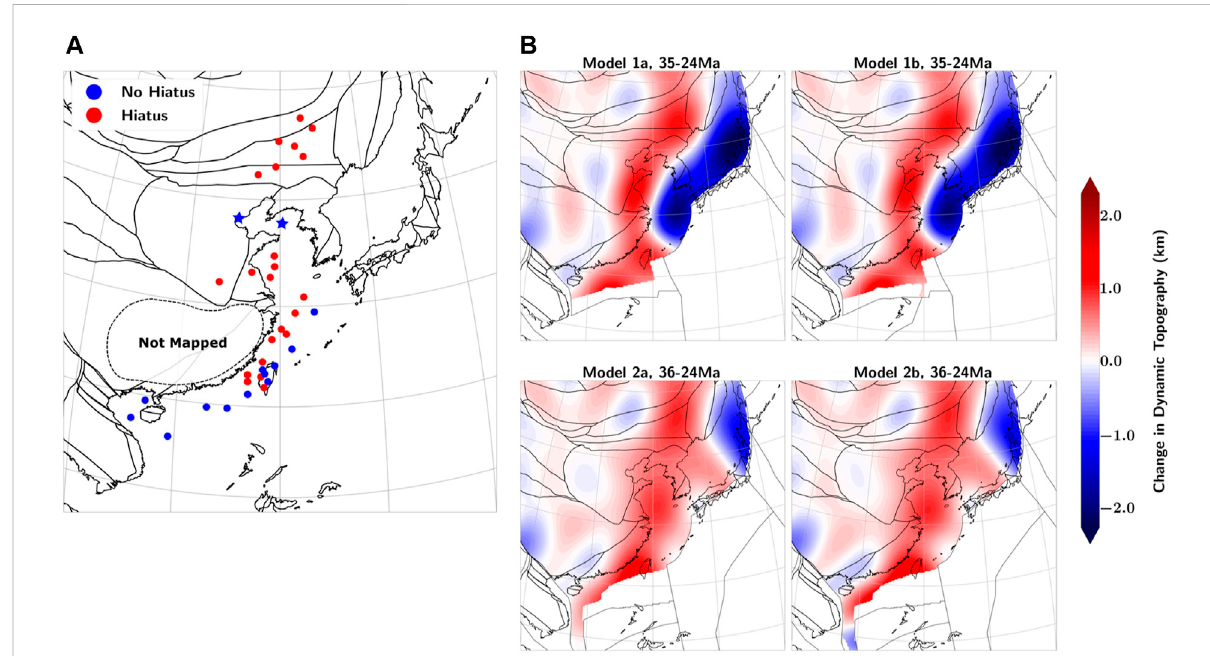
FIGURE 6 (A) Base of Miocene hiatus map for the sedimentary basins in eastern China and exposed Cenozoic strata in Taiwan. Blue stars mark the locations of Bohai Bay Basin (west) and North Yellow Sea Basin (east), which are mapped as No Hiatus but are consistent with a regional uplift event (seediscussionintext).Noticethat theSCB(outlinedbyadashedline)isexcludedfromourmapping. Thisregion ischaracterisedbyadistinctlackof Cenozoic sediments (cf. Figure 1) meaning that Cenozoic uplift events in this area can be more easily gauged via AFT thermochronology (Section 4.3). (B) Change in dynamic topography during the Oligocene predicted by the mantle circulation models of Lin et al.